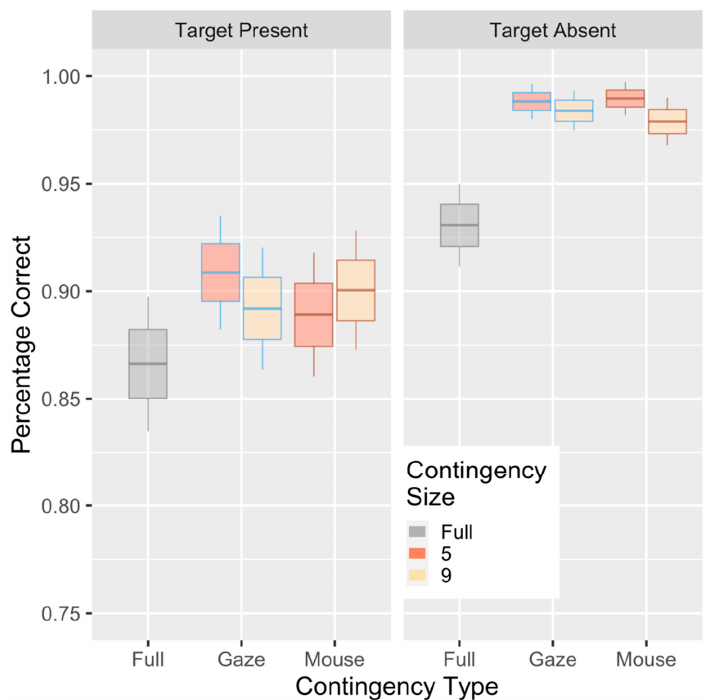
Figure 2. Accuracy for the base condition, as well as the mouse- and gaze-contingence conditions, shown as a function of whether a target was present or absent and the size of the aperture. Box plots represent category mean (center), standard error (box), and 95% CI (whisker).